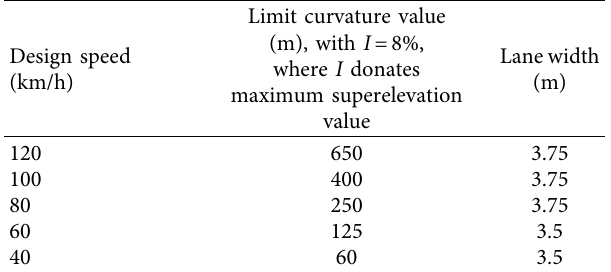
Table 1: Design of curvature and lane width in “Design Specif- cation for Highway